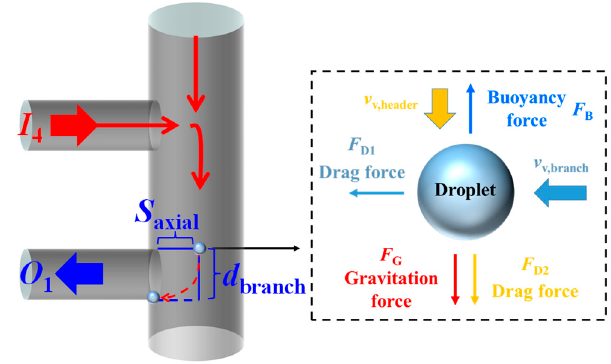
Figure 10. Forces on droplet in the header.